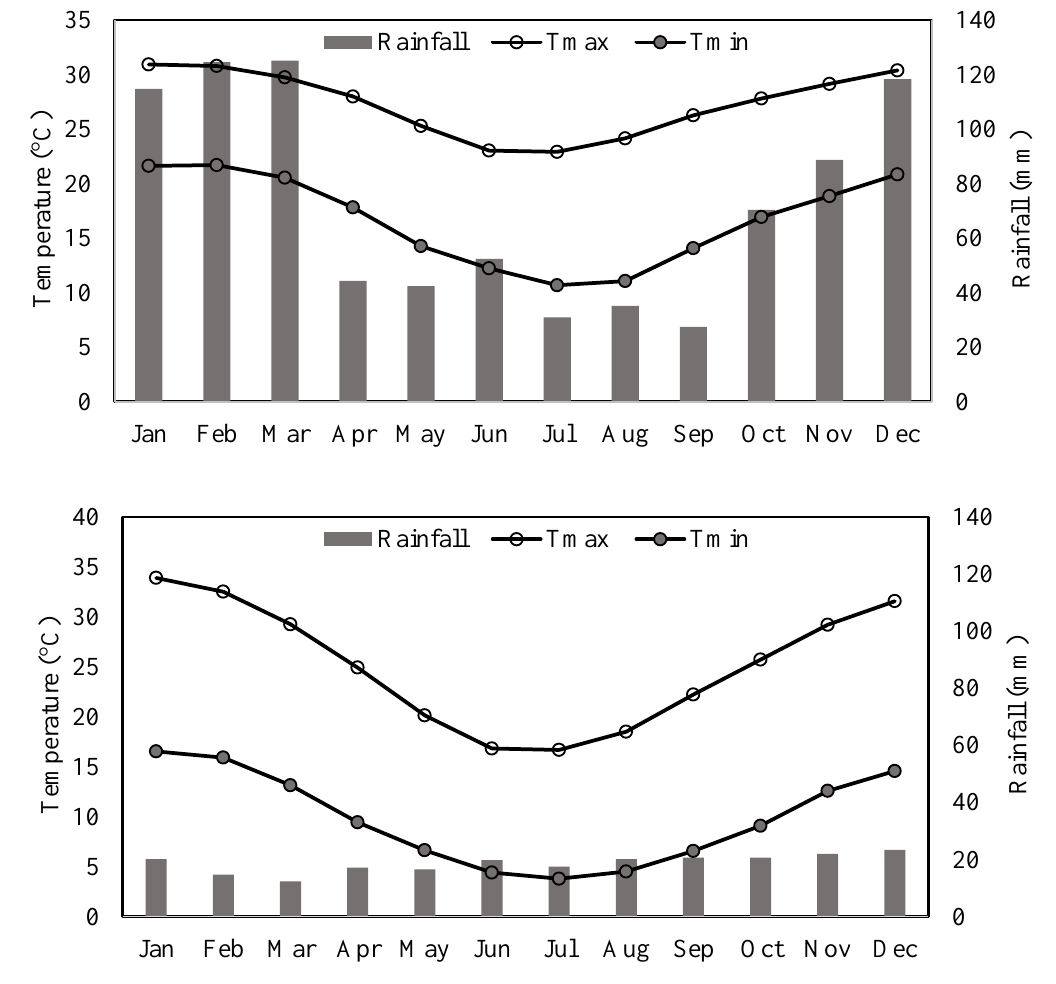
Figure 2. Monthly averages of the maximum (Tmax) and minimum (Tmin) air temperatures ( ◦ C), along with the monthly average rainfall (mm) for the Bundaberg ( top ) and Renmark ( bottom ) study regions